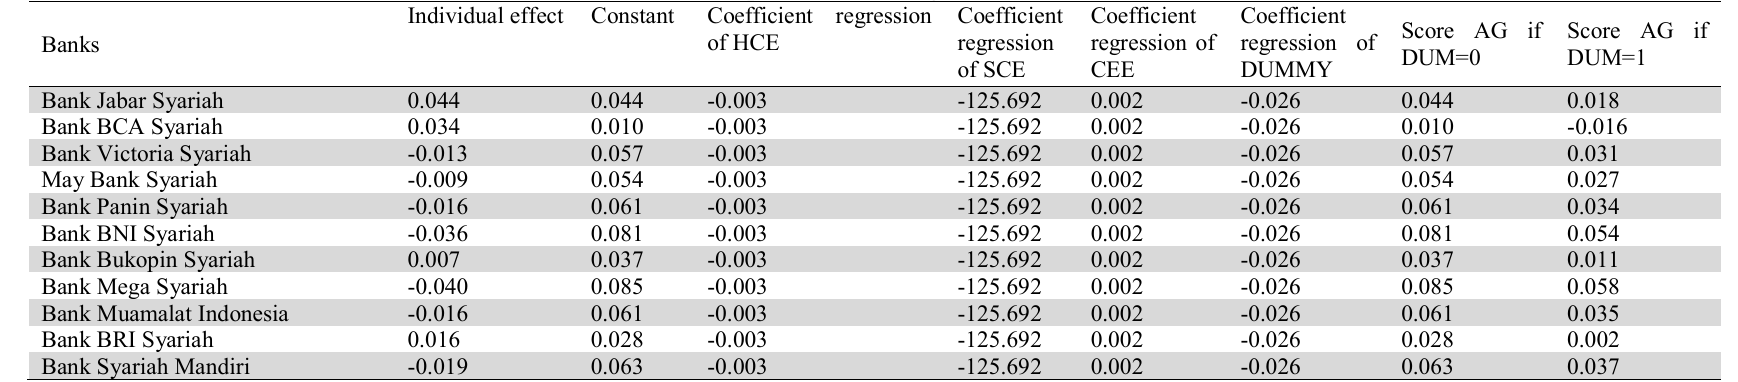
Assets Growth of Islamic Bank in Indonesia, which have a competitive